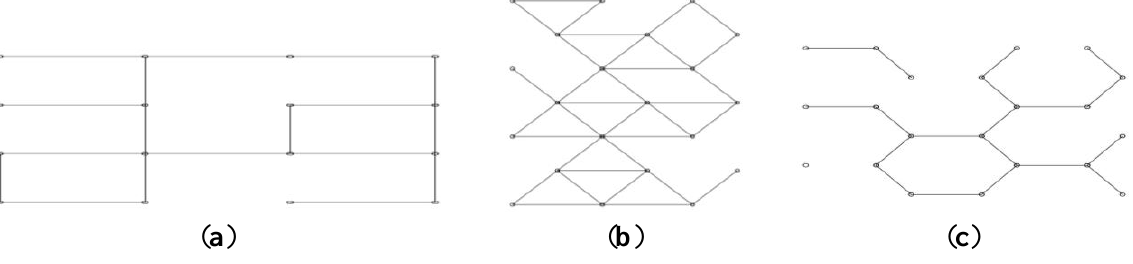
Figure 2. Functioning nanosensors with ( a ) square lattice (SL), ( b ) equilateral triangle lattice (ETL), and ( c ) hexagonal lattice (HL) structures. The nanowires which are not shown are considered to have